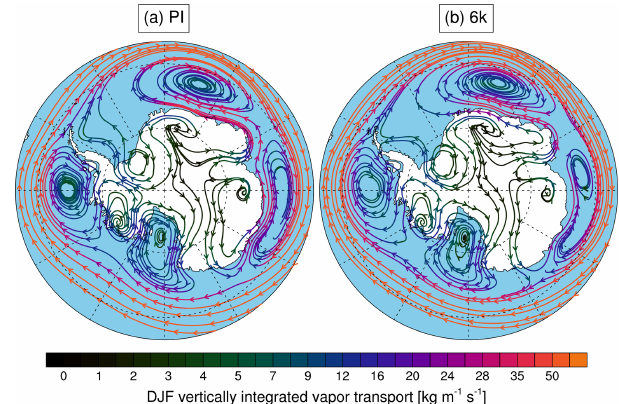
Figure 12. Vertically integrated water vapor transport over Antarc- tica during austral summer for PI (a) and 6k (b)